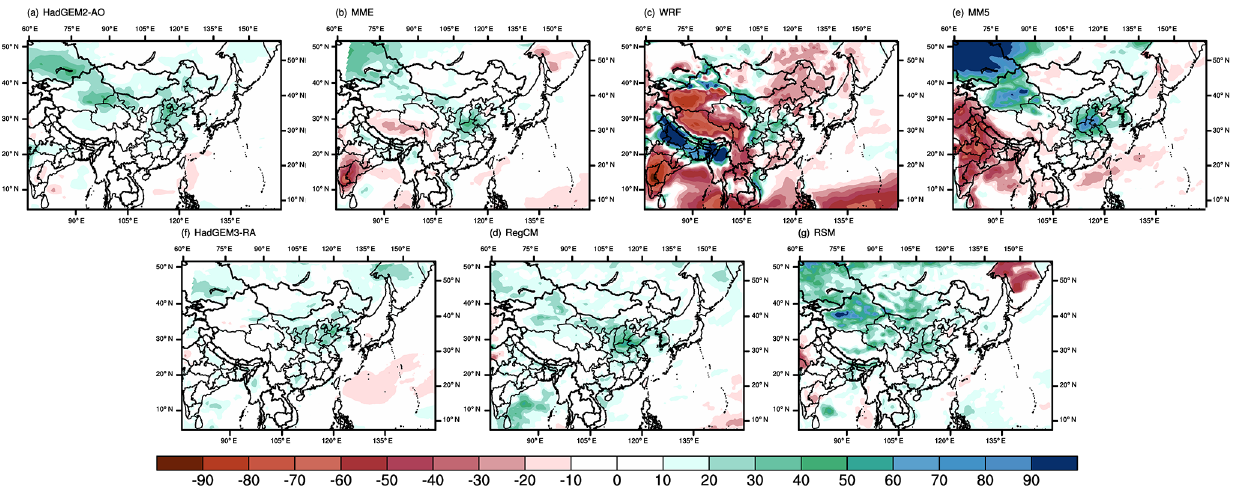
Figure 8. Projected future changes ((RCP4.5 − baseline) / baseline × 100%) in precipitation by the forcing GCM HadGEM2-AO, the MME, and each of the five